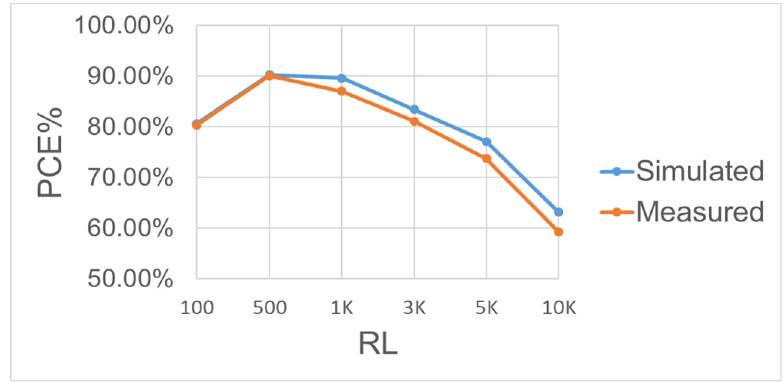
Figure 34. Measured and simulated power conversion efficiency of the BST rectifier operating at 2 MHz with VAC = |3.3 V| and different loadings.